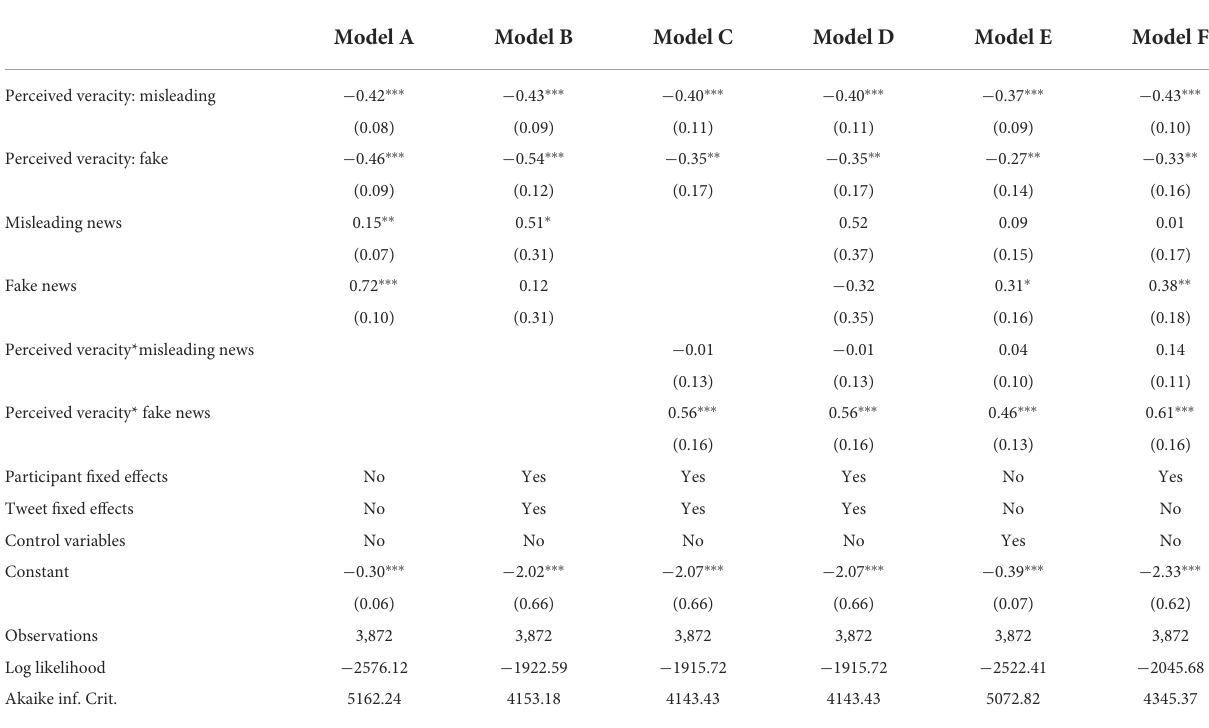
TABLE 5 Logit regression: reaction likelihood.